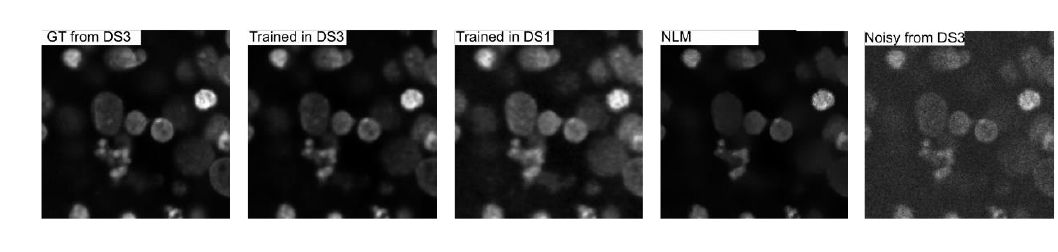
Figure: A) The comparison of the ResUnet with RCAN and NLM algorithm reconstruction of a Noisy input 10msec exposure (Noisy) for a Noci cell image slice from Dataset 2 with the corresponding GT (500msec exposure). Both ResUnet and RCAN have been trained in a different dataset 1. Characterized by different optical systems, fluorophores, and cameras. B) the line profile of the panel A for the line shown above C) The Cumulative probably of the intensity which is characterized by the Kolmogorov distance (vertical line) for panel A. D) The MSE, SSIM, Cumulative probability improvements for Panel A. E) We define the signal Improvement as the slope between the KLinput and the KLResUnet scatter plot linear fit. which we find for each different dataset here shown just for one characterized by the parameter F) The Signal improvements for different datasets with different Ω = of ResUnet for the same DS trained and different and comparison with the